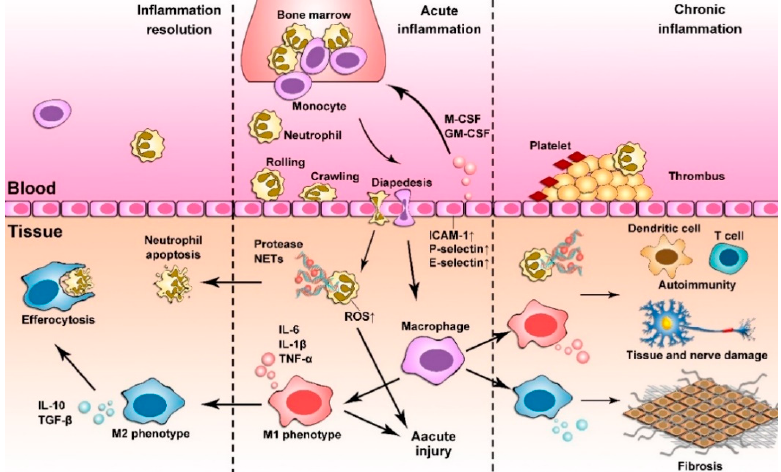
Figure 1. Neutrophils and macrophages regulate inflammatory responses. In acute inflammation, neutrophils and monocytes are quickly released from the bone marrow and transmigrate into infected or injured tissues. These processes are regulated by macrophage colony-stimulating factor (M-CSF) and granulocyte macrophage-colony stimulating factor (GM-CSF). Monocytes differentiate in the tissues to become macrophages and may polarize to an M1 phenotype and release pro-inflammatory factors. Activated neutrophils secrete neutrophil extracellular traps (NETs) and proteases that are also involved in the functions of M1 macrophages during acute inflammation. In the phase of inflammation resolution, NETs and proteases are degraded and neutrophils become apoptotic, while macrophages efferocytose neutrophils and dead tissues. In addition, there is a macrophage transition from M1 to M2 during resolution of inflammation. If resolution of acute inflammation fails, persistent activation of neutrophils and macrophages mediates the pathogenesis of a wide range of vascular diseases. In a chronic inflammation phase, neutrophils and macrophages activate and regulate platelets and adaptive immunity to form a new homeostasis phase that leads to inevitable tissue damage and